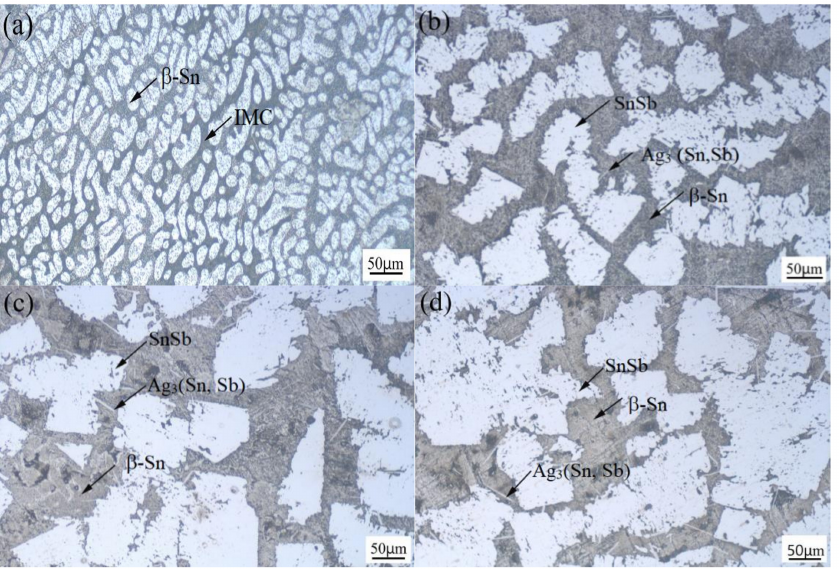
Figure 1. The microstructure of the Sn-3.0Ag-0.5Cu-xSb solder alloy: ( a ) x = 0, ( b ) x = 25, ( c ) x = 28, and ( d ) x =